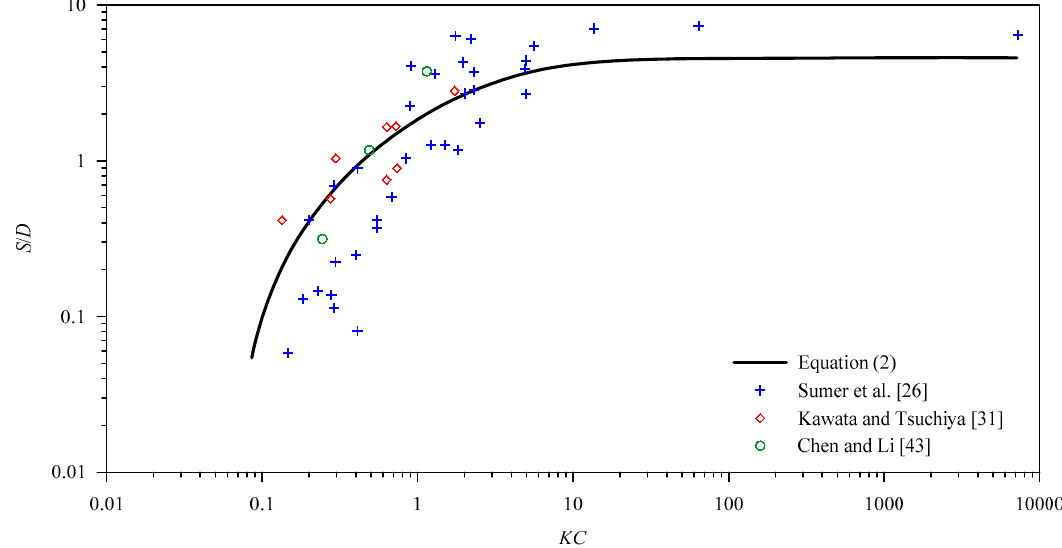
Figure 5. Nondimensional scour depth, S / D , versus Keulegan–Carpenter number, KC number, under waves.